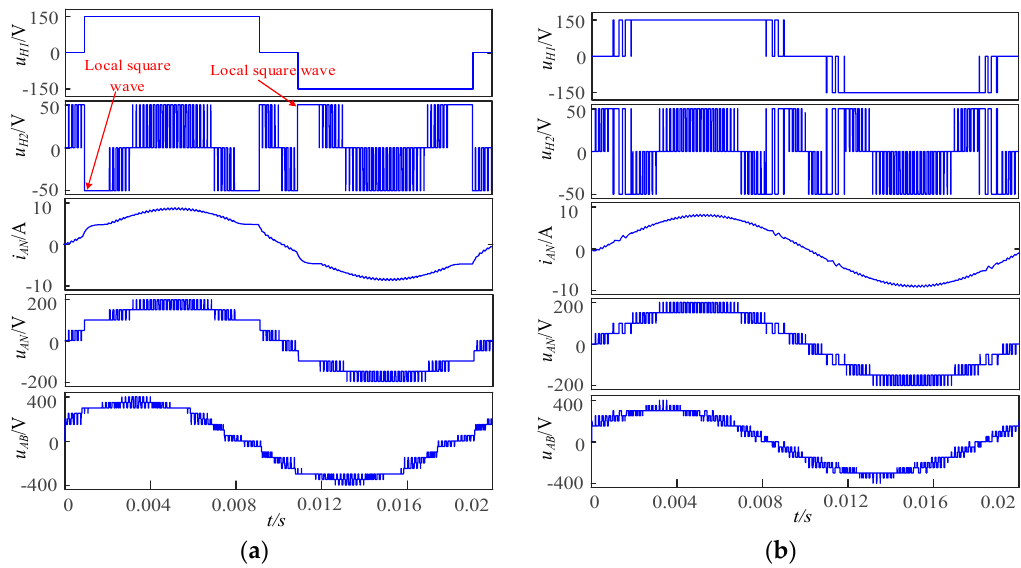
Figure 5. Simulation voltage waveforms. ( a ) HF-PWM strategy simulation waveform, ( b ) MHF-PWM.